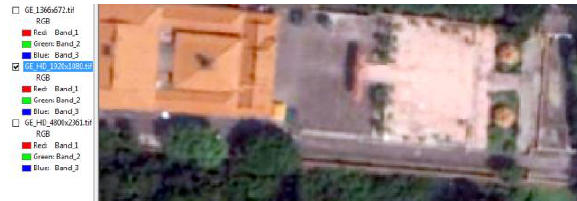
Figure 12b. HD (1920 x 1080) –clearer image compared minimum resolution -